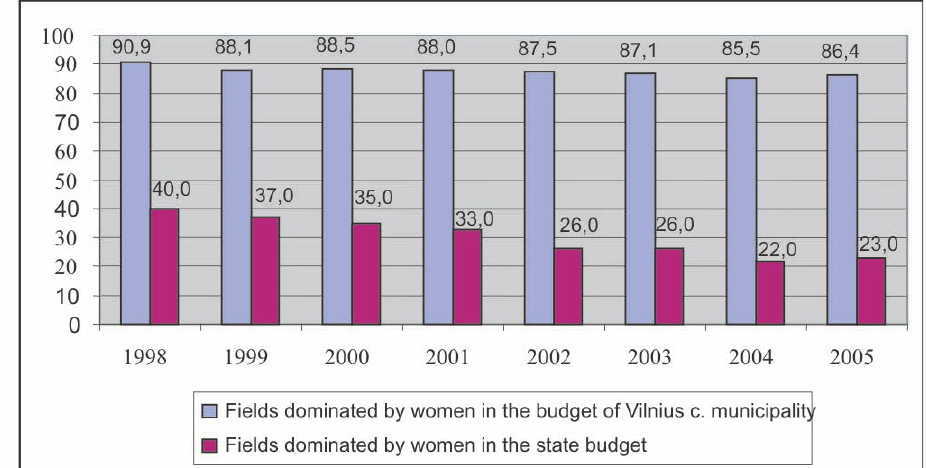
Fig 5 . Allocations to the “female” sectors from municipality and state budgets, 1998–2005,